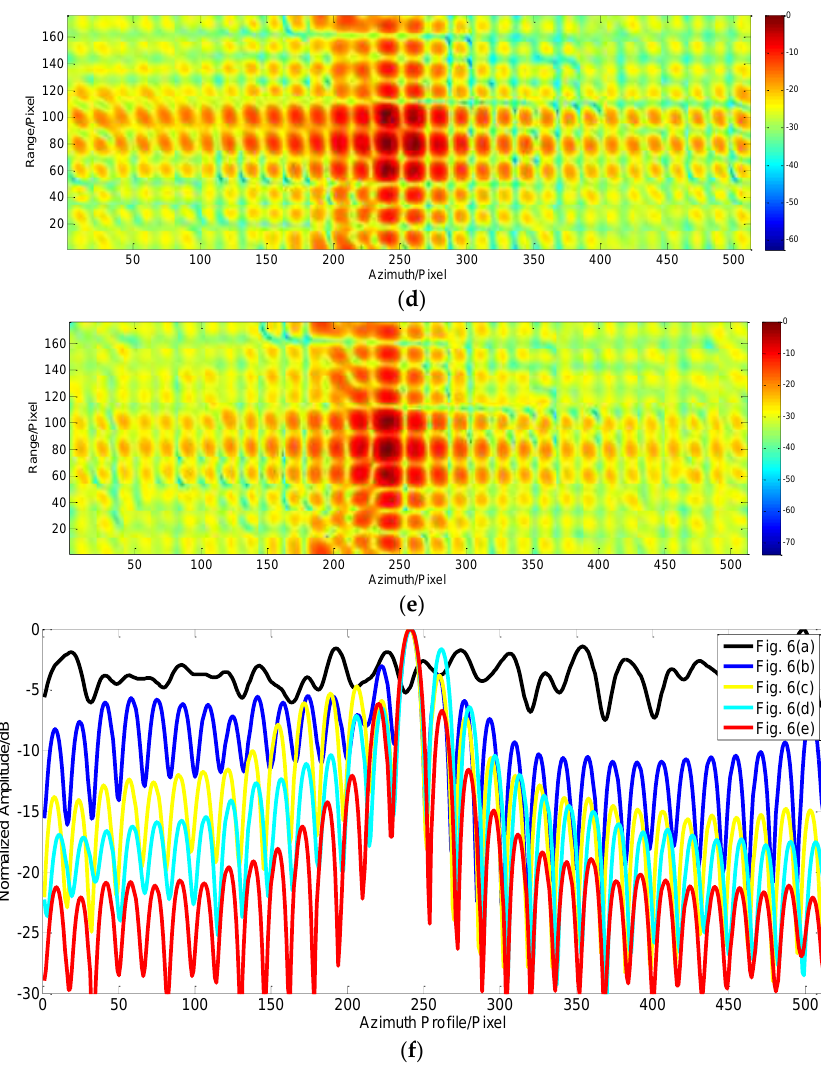
Figure 6. Point spread functions and azimuth profiles of bight targets in Figure 5. ( a ) Focused without MOCO; ( b ) Focused with only range-varying PGA; ( c ) Focused combining stripmap RDM and range-varying PGA; ( d ) Focused combining sliding spotlight RDM without WTLS and range-varying PGA; ( e ) Focused combining sliding spotlight RDM with WTLS and range-varying PGA; (f) The azimuth profiles of the brightest target in Figure 6a–e.